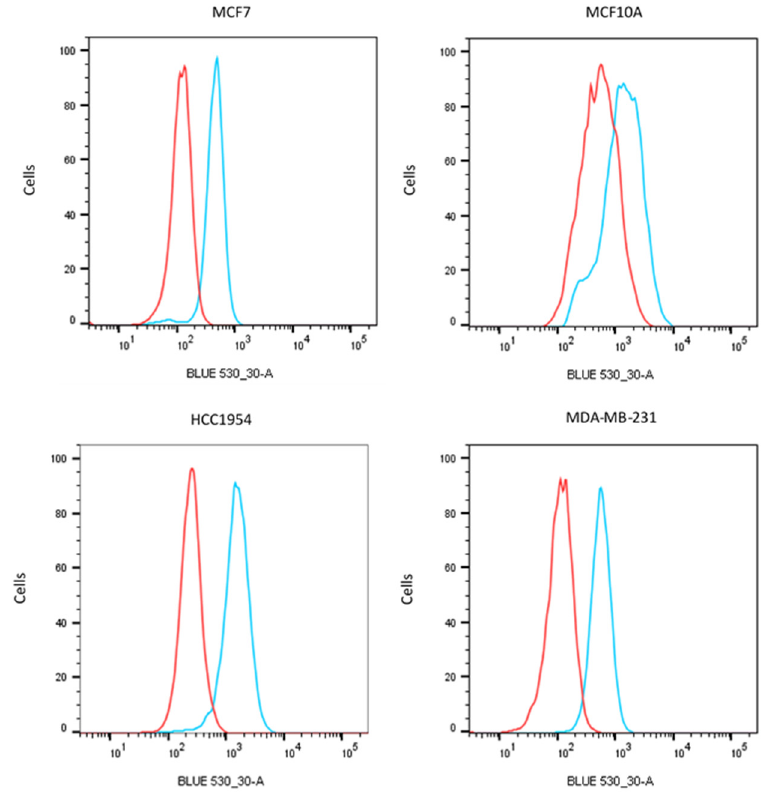
Figure 4. Presence of EphB4 on breast cancer cell lines MCF-10A, MCF7, MDA-MB-231, and HCC1954 indicated in blue versus control in red.